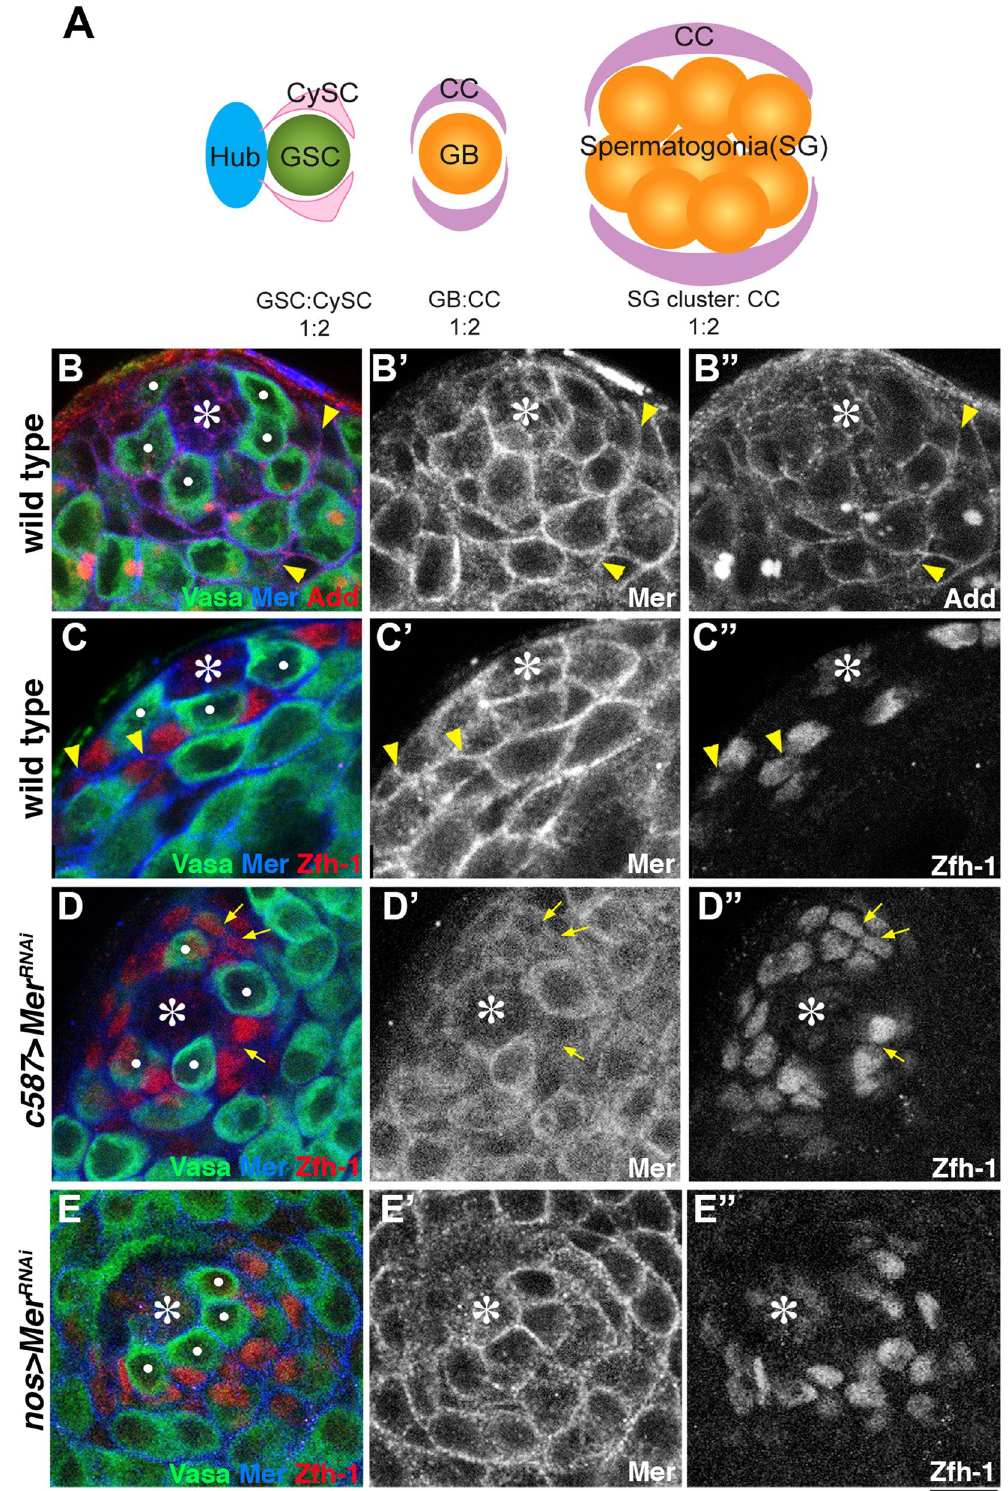
Figure 1. Mer protein localizes to the surfaces of CySCs and CCs. ( A ) Diagram of the Drosophila testicular stem cell niche. GSCs and CySCs are attached to the hub cells, where each GSC is encapsulated by a pair of CySCs. GB, the differentiating daughter of a GSC, which will become spermatogonia (SGs), is encapsulated by a pair of CCs generated by CySC divisions. ( B and C ) The wild-type testis apical tip shows Mer protein localization on the cell surface (arrowheads). The pseudocolor of immunofluorescent staining is shown in the colored text. GSCs are indicated by white dots. Bar, 10 µ m. Hub ( * ). ( D ) RNAi-mediated knockdown of Mer in the CySC lineage ( c587 > Mer RNAi ). Residual cytoplasmic staining can be seen in the germline. ( E ) RNAi-mediated Mer knockdown in the germline ( nos > Mer RNAi